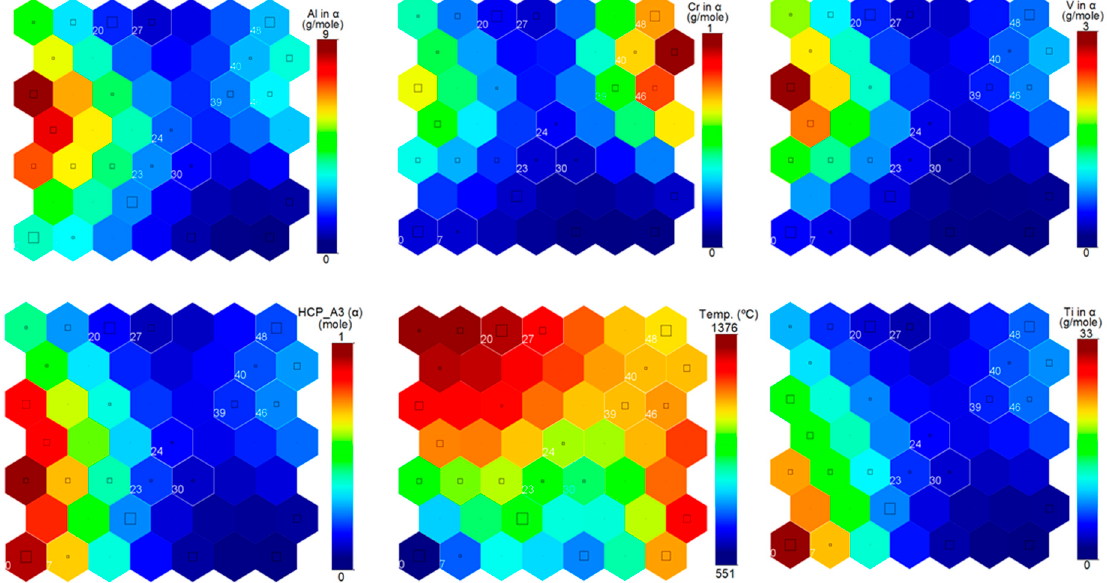
Figure 5. Distribution of alloying elements in the HCP_A3 phase.